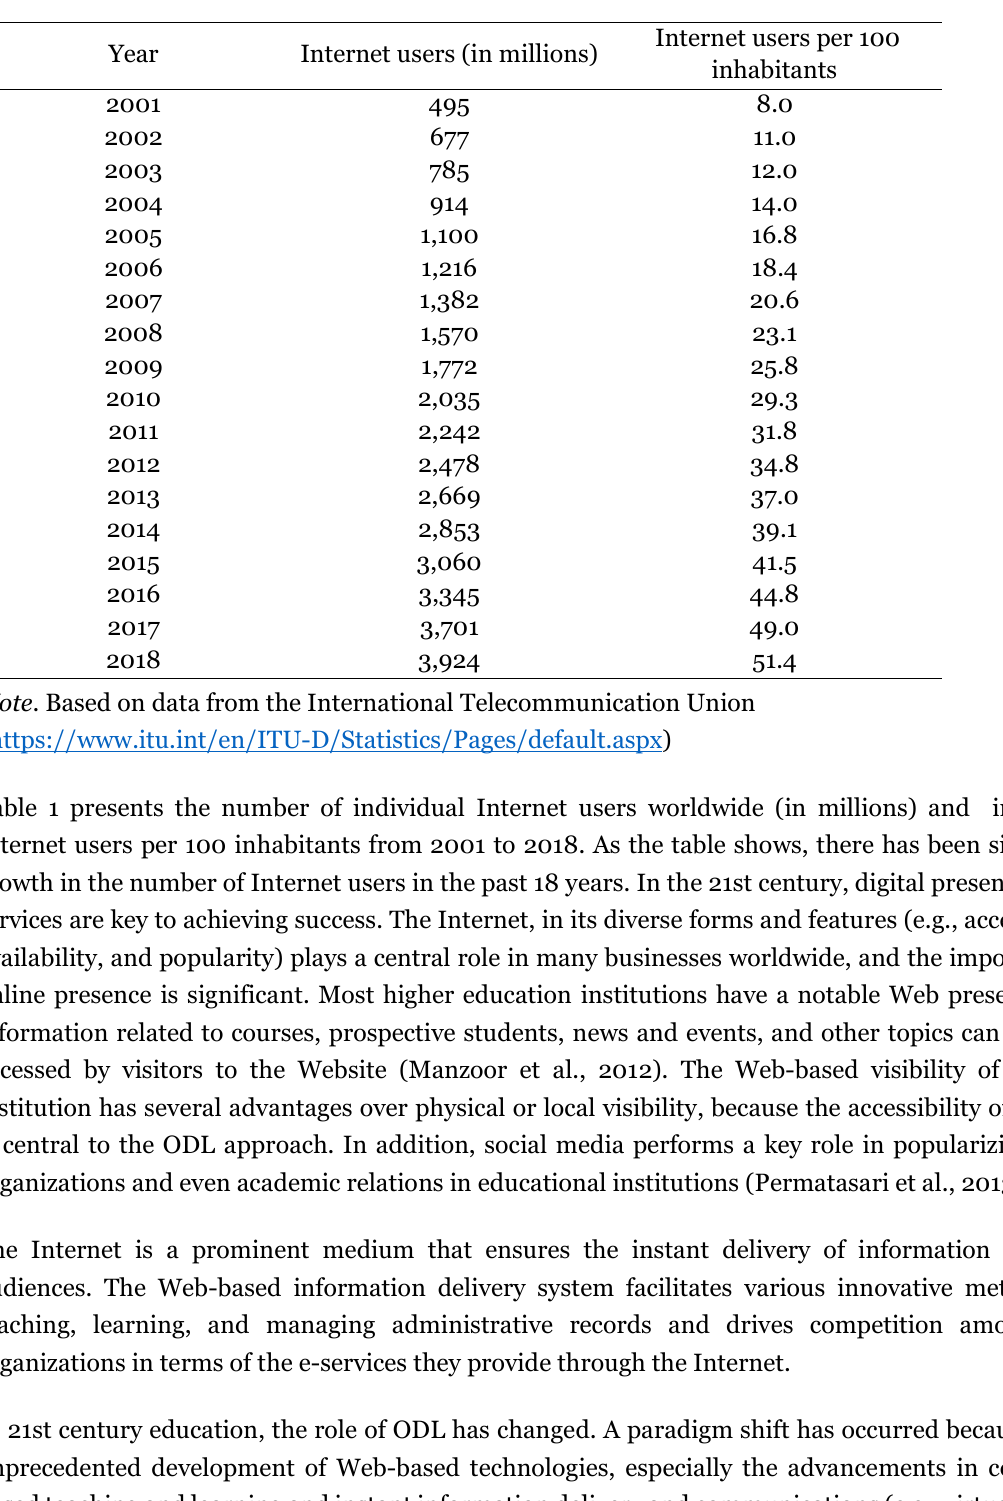
Total Number of Individual Internet Users Worldwide